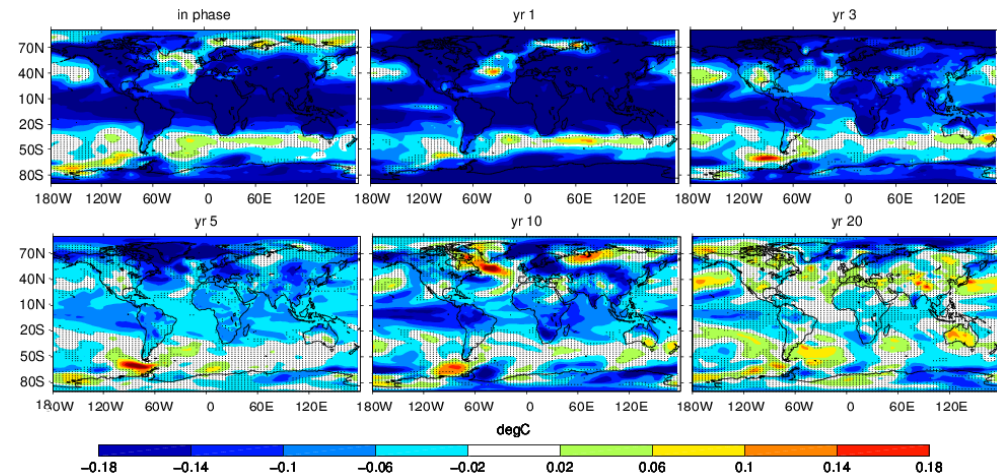
Fig. 5. Composites of annual mean anomalous surface temperature for different time lags (in years) with respect to the volcanic eruptions corresponding to optical depths higher than 0.15. Surface temperature corresponds to SST over the ocean and air temperature otherwise. Dotted areas are not significant at the 5% level